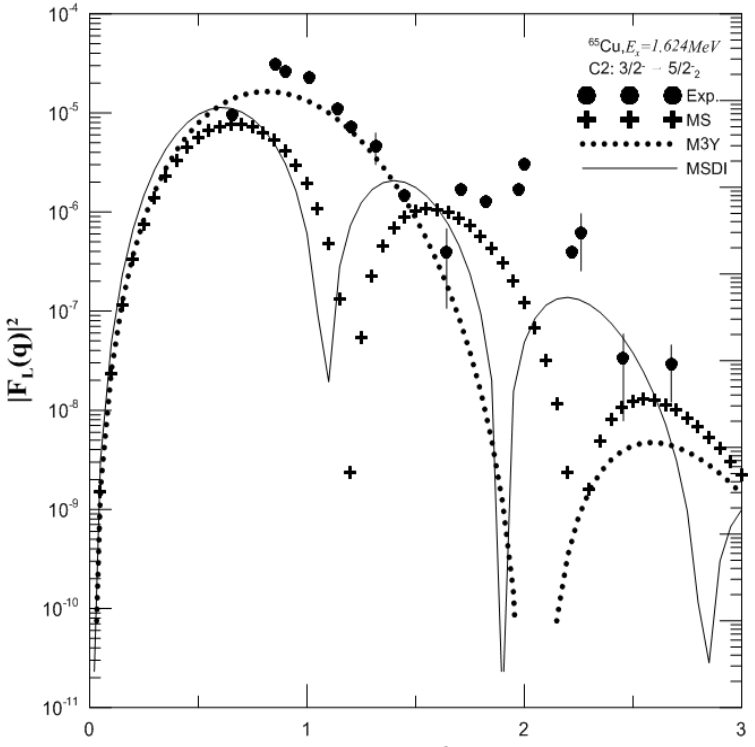
Fig.6: Inelastic longitudinal form factors for C2 transition 3/2 -  using MSDI and M3Y interactions with core-polarization effects, through particle-hole excitations up to 6ћω. The experimental data are taken from Ref.